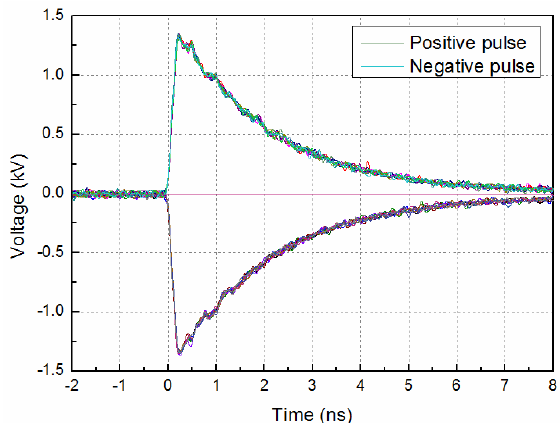
Figure 5. The output waveforms at a bias voltage of ± 2.0 kV and a laser pulse energy of 97.5 μJ .